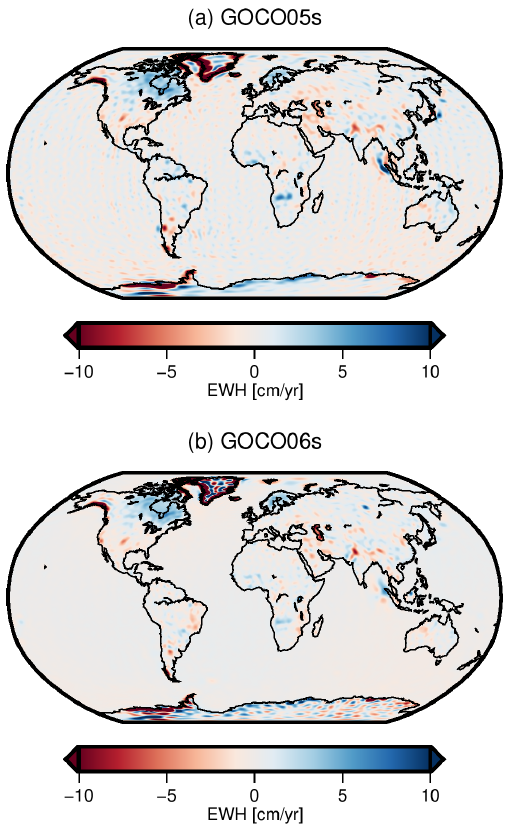
Figure 2. Co-estimated secular variation of GOCO05s (a) and GOCO06s (b) in equivalent water heights